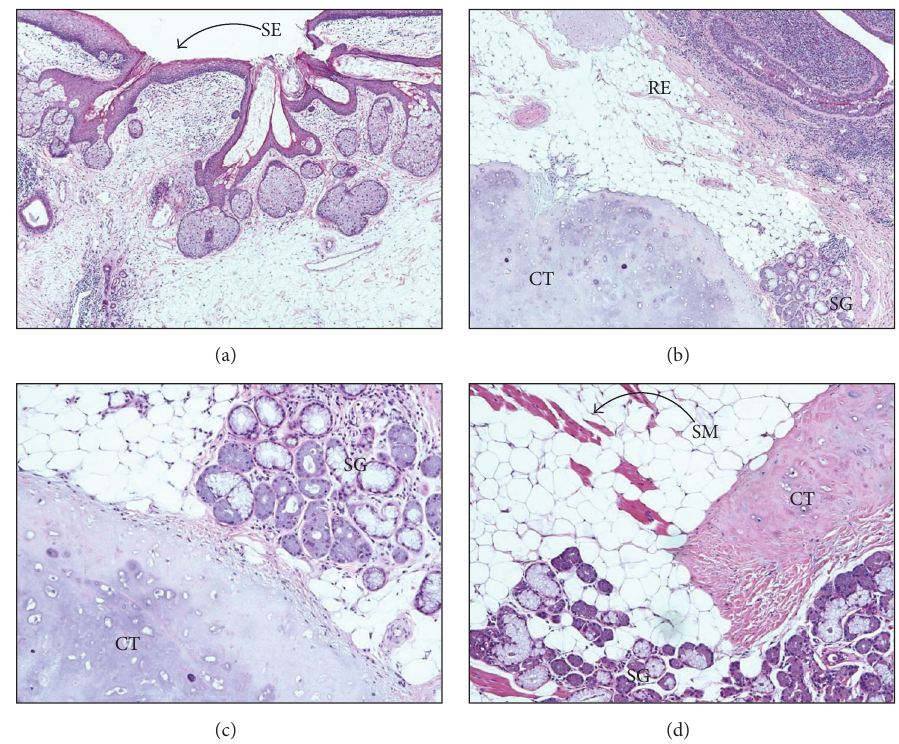
Figure6:Representativehistopathologyphotomicrographsoftheskullbaseteratoma.(a)Stratifiedsquamousepithelium(SE)withassociated adnexalstructures(4xmagnification).(b)Ciliatedrespiratoryepithelium-(RE-)linedcysticstructure,salivaryglandtissue(SG),andcartilage (CT) (4x magnification). (c) Scattered foci of SG adjacent to CT tissues (10x magnification). (d) Haphazard arrangements of CT, SG, and striated muscle (SM) (10x magnification). Mature adipose tissue is also present in the background (unlabeled clear cell